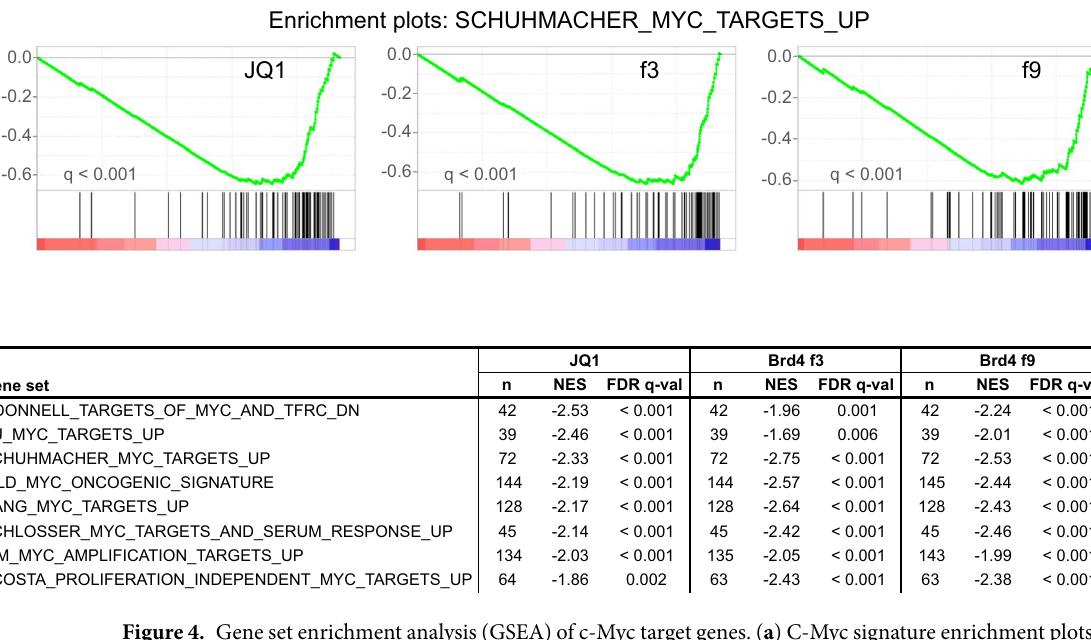
Figure 4. Gene set enrichment analysis (GSEA) of c-Myc target genes. ( a ) C-Myc signature enrichment plots in Raji-luc + 500 nM JQ1, Brd4 f3, and Brd4 f9 cells versus DMSO-treated Raji-luc cells as a control for all three conditions. Plots were prepared using the SCHUHMACHER_MYC_TARGETS_UP 24 dataset (containing genes upregulated by c-Myc) available at the Molecular Signatures Database 51 . C-Myc upregulated target genes were enriched at the bottom of the ranked list of genes (ranking according to log2 fold-changes obtained from the previous DE analysis), indicating that genes upregulated by c-Myc tended to be repressed. ( b ) Table of selected c-Myc target gene sets 24–31 enriched in all three samples. n = number of genes in each set; NES = normalized enrichment score; FDR q-val = test of statistical significance. Negative NES indicates that genes in the respective target gene sets tended to be